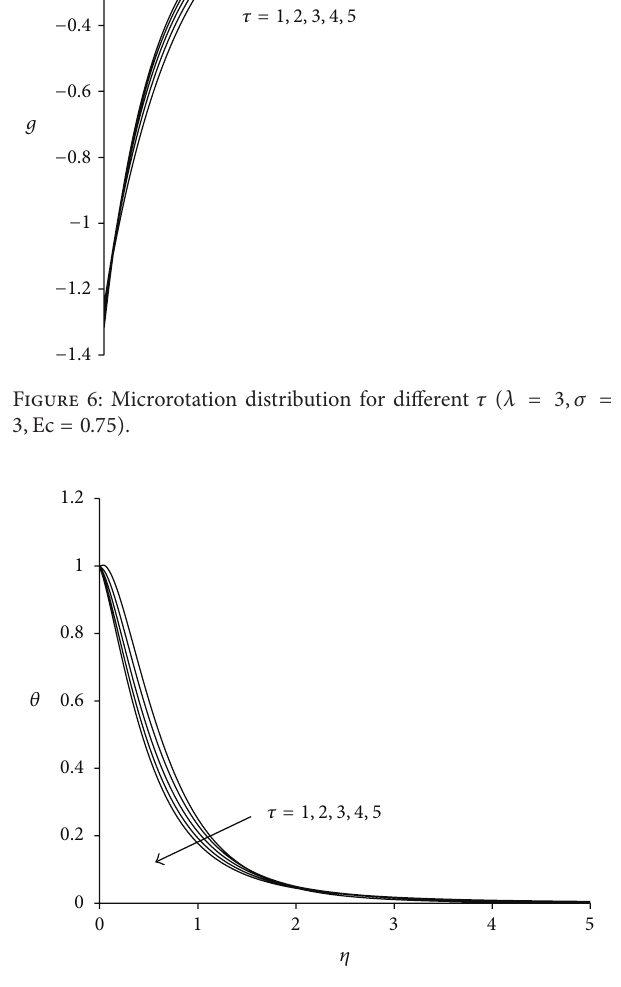
Figure 7: Temperature distribution for different 𝜏 (𝜆 = 3, 𝜎 = 3, Ec = 0.75)